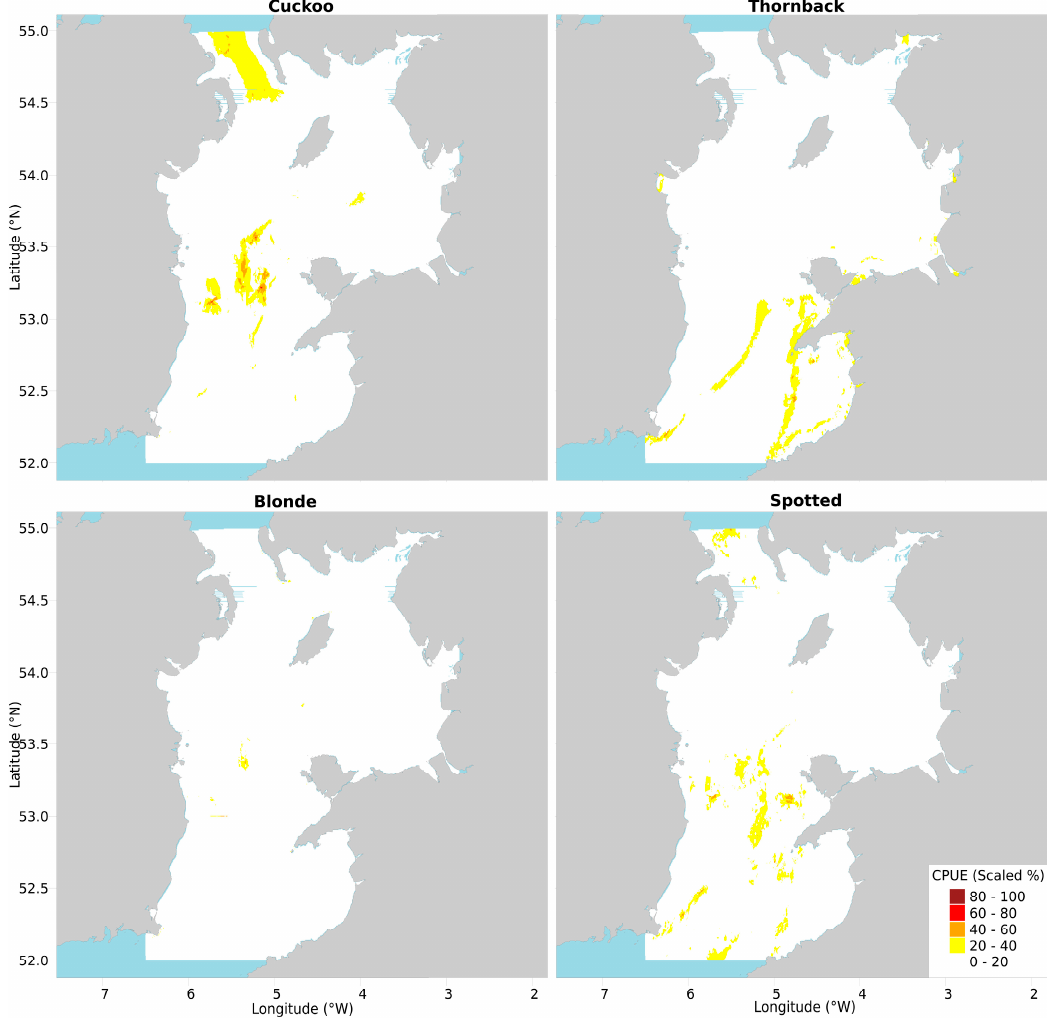
Figure 3. Combination map: model predicted combined CPUE of juvenile plus mature female rays, each scaled to maximum CPUE per subset then summed, used to infer conservation value. Values are therefore a percentage of each subset’s maximum.